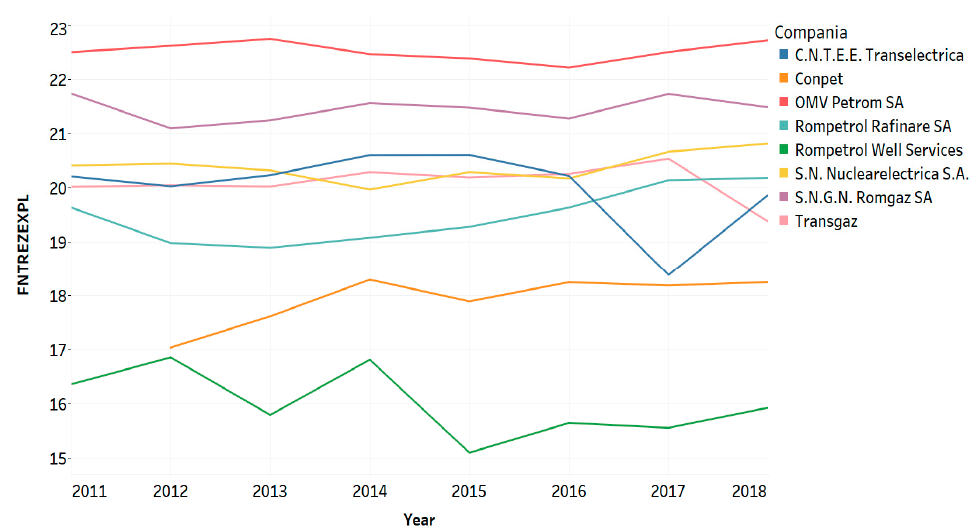
Figure 1. Evolution of the FNTREZEXPL for the companies in the sample. Source: authors’ construction in Tableau 2020.1.0.